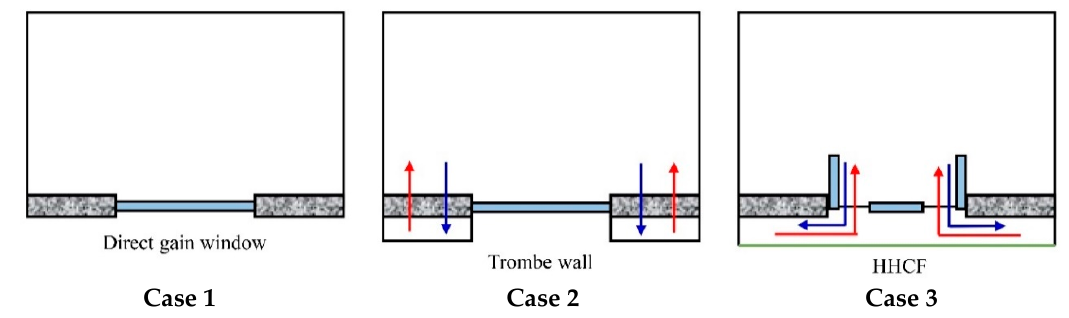
Figure 10. Three cases studied.